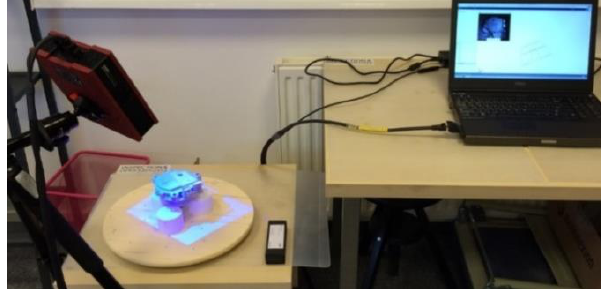
Fig. 6. Optical scanning process of an camshaft control motor using GOM's ATOS